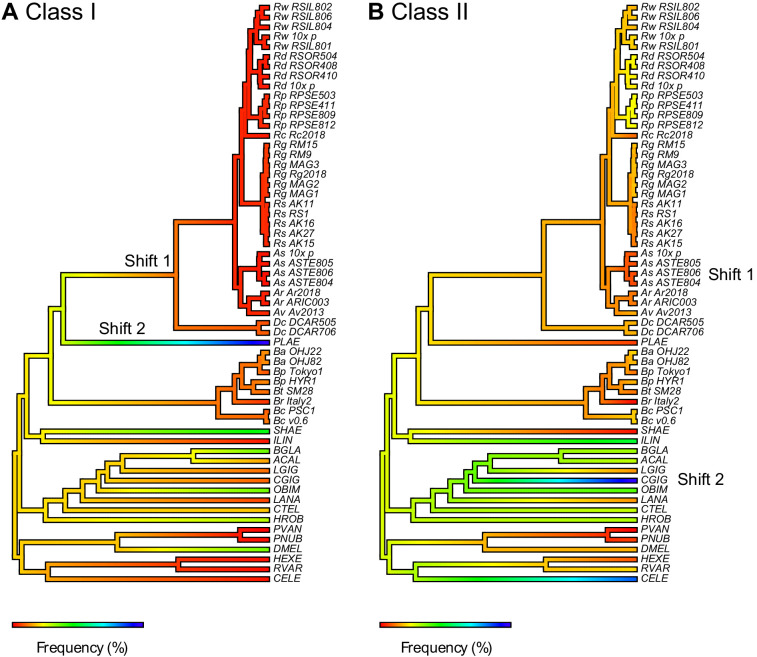
TE content mapped as a continuous trait onto protostome phylogeny.Frequency of (A) Class I and (B) Class II TEs shown separately. Repeat content is mapped as a percentage of genome span, with blue indicating a relative increase and red indicating a relative decrease in TE type along a given branch of the phylogeny. Significant shifts in the frequency or rate of change are indicated on branches with yellow stars (see Figure 2—source data 4 for details on model output).